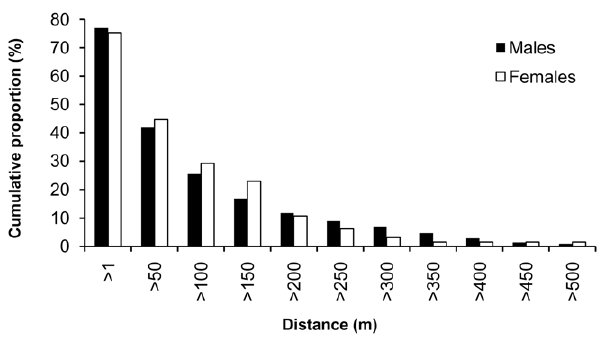
Figure 3. Cumulative proportion of individuals of the Rosalia longicorn in dependence on their lifetime movements. Data from the mark-recapture study were combined from years 2008 and 2009. Distances of 0 m (recaptures caught at the same place) were excluded, the rest were divided in 50 m classes ( N males = 164, N females =49 ).